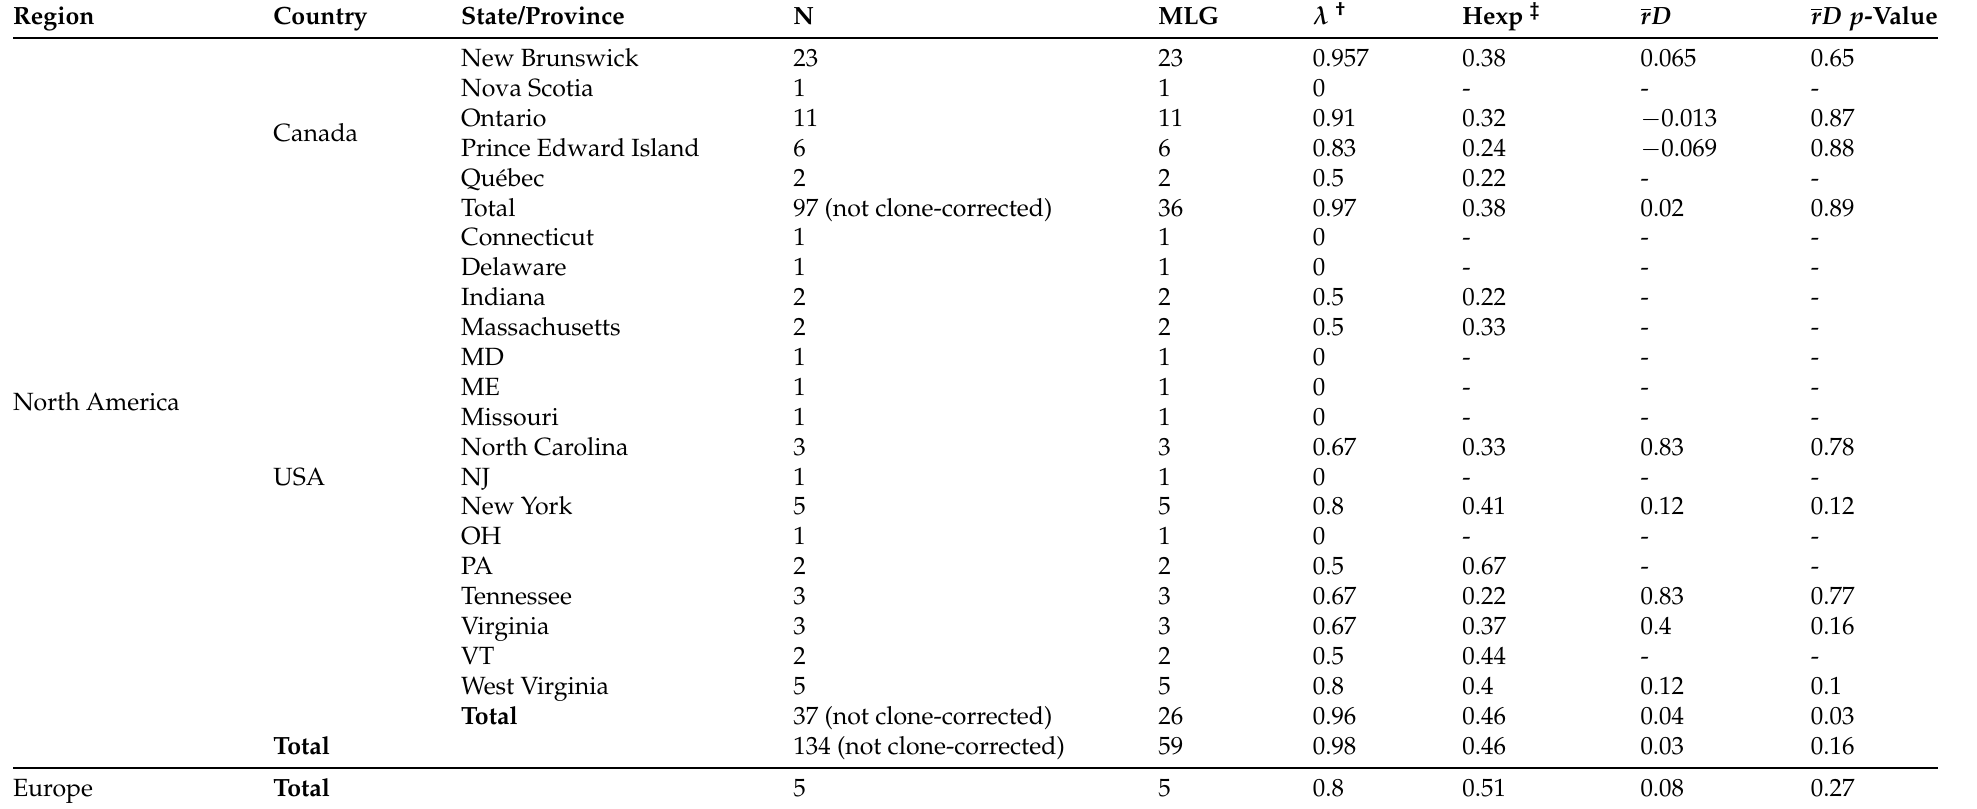
Table 2. Microsatellite genotypes and population genetic metrics from 139 isolates presented in this study. All metrics were clone-corrected at the Province/State level. Tests of standardized index of association ( rD ) are paired with simulated p -values generated from a randomization tests, conducted over 1000 permutations of the test statistic.